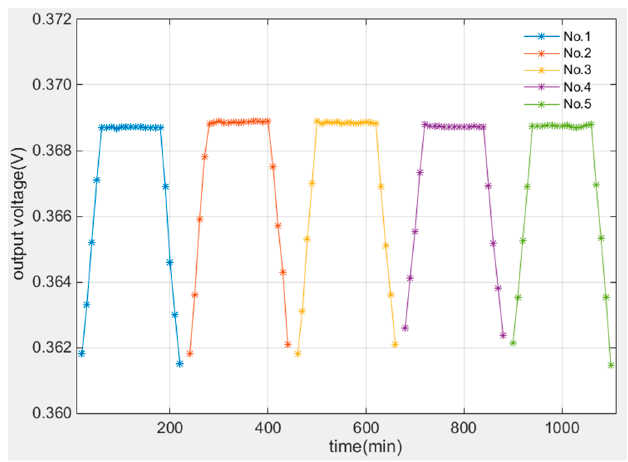
Figure 12. Heat resistance test results at high temperature.